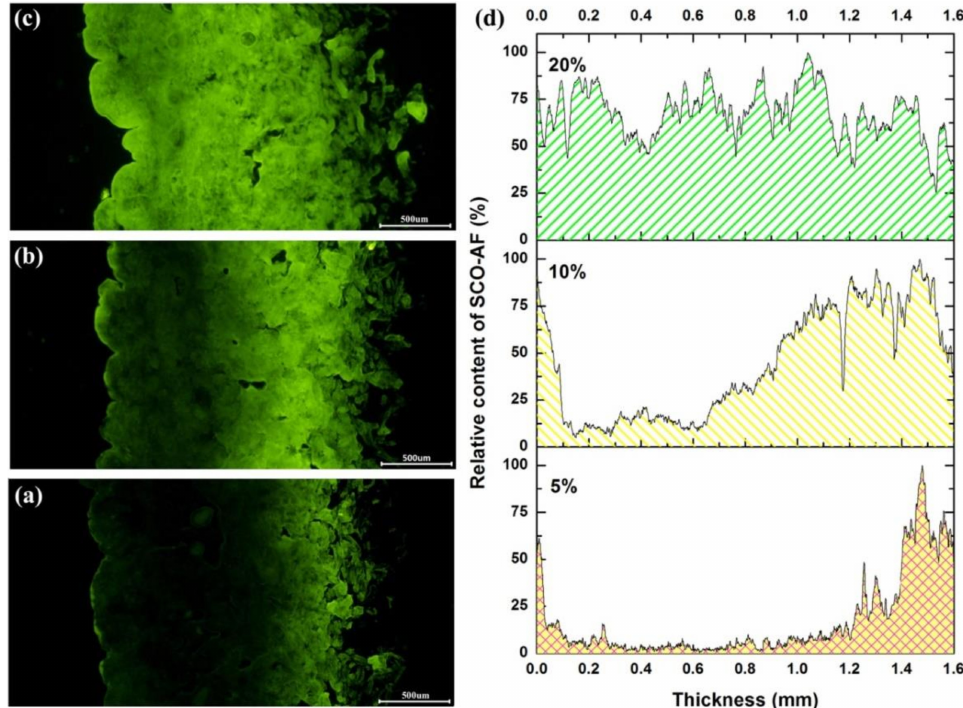
Figure 8. Fluorescence micrographs of different amount of AFSCO distributing in leather: ( a ) 5%, ( b ) 10%, ( c ) 20% and ( d ) quantification analysis of fluorescence